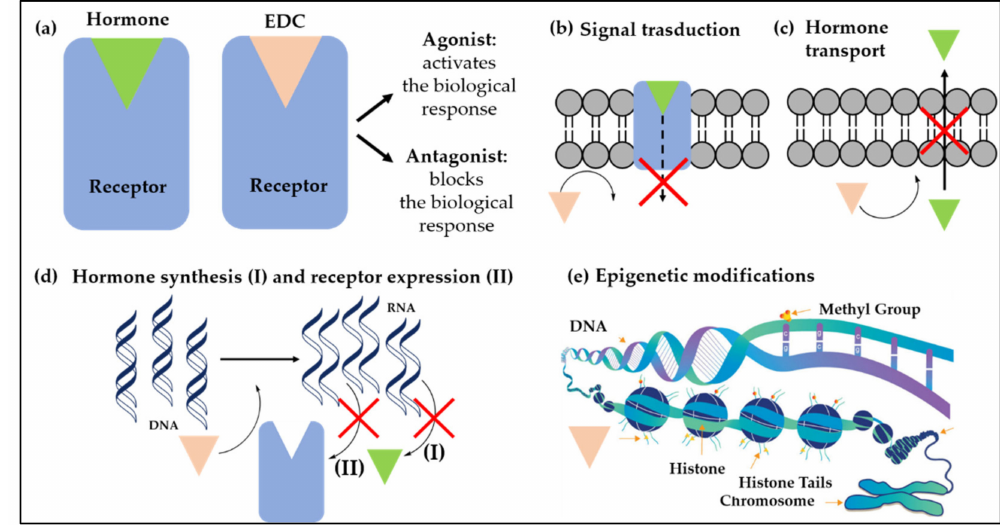
Figure 4. Schematic representation of the main EDC modes of action: ( a ) bind to hormone receptors acting as agonist or antagonist; ( b ) alter signal transduction; ( c ) block hormone transport across cell membranes; ( d ) alter hormone synthesis or receptor expression; ( e ) induce epigenetic